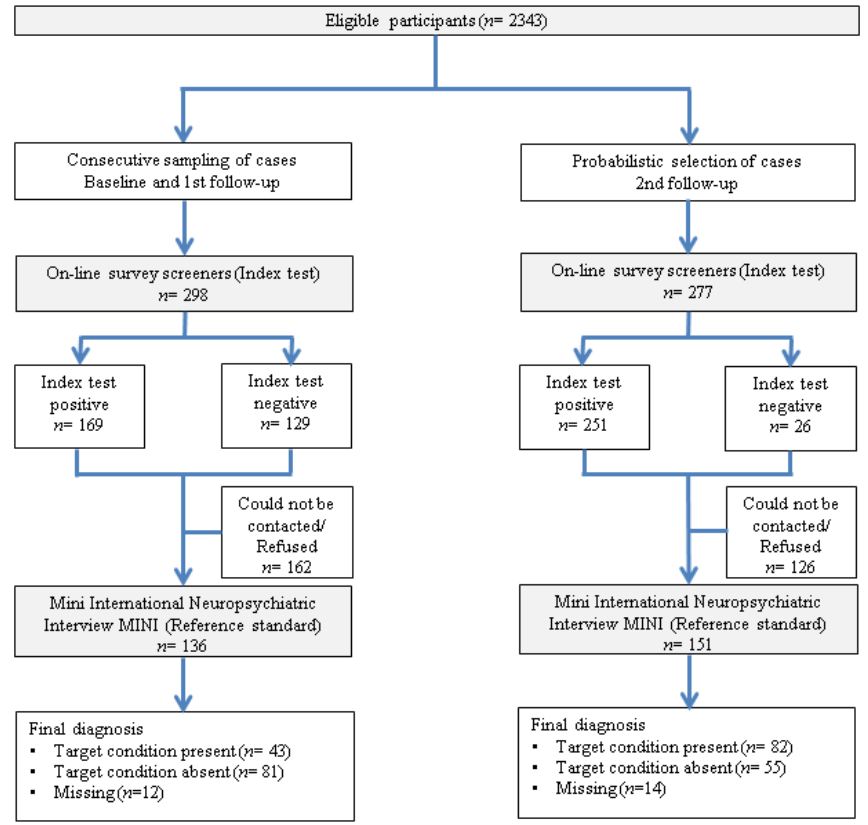
Figure 1. Flow diagram of the clinical reappraisal study based on STARD 2015 guidelines [33].